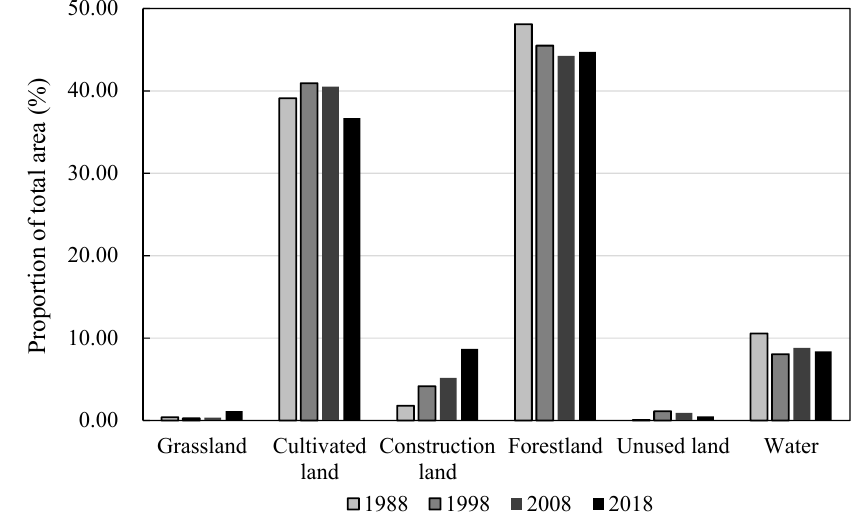
Figure 4. Land-use changes in the PLEEZ from 1988 to 2018.